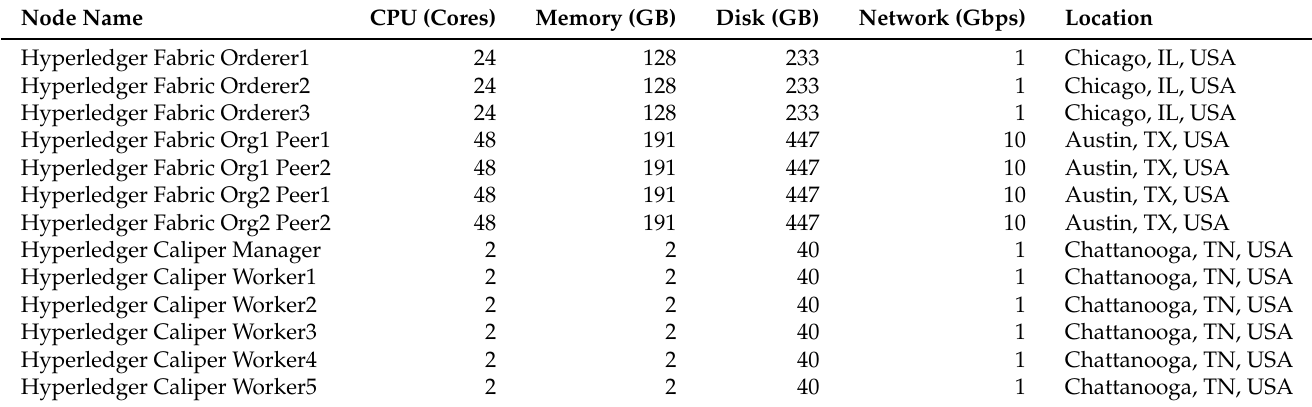
Table 2. Hardware configurations of Hyperledger Fabric nodes and Hyperledger Caliper